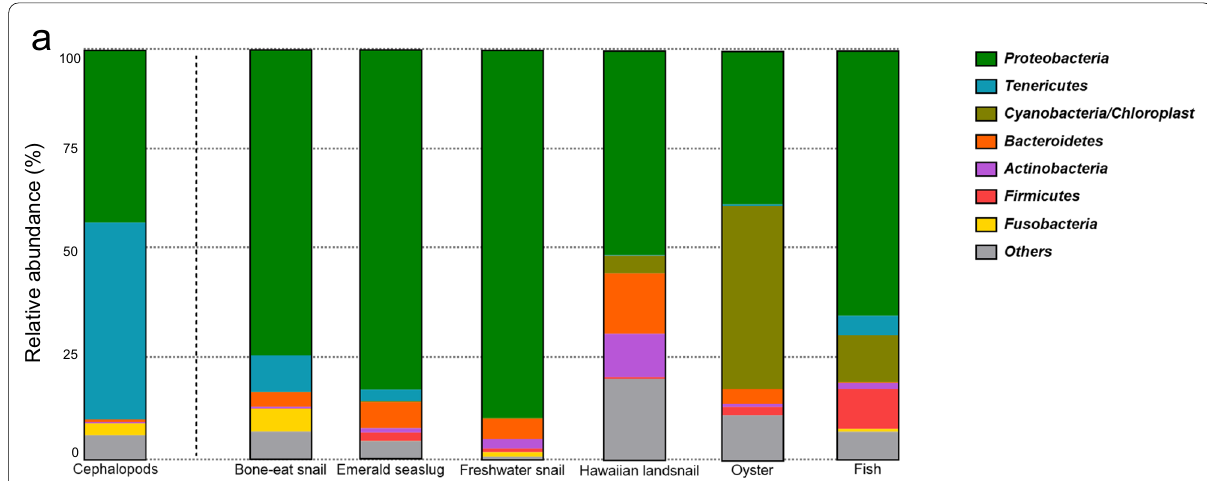
Fig. 5 Gut microbial community structure of mollusks and fish. a Bar charts of the relative abundance of bacterial phyla in cephalopods, other mollusks, and fish. Only genera with a relative abundance of > 0.5% are shown; those with < 0.5% are classified as